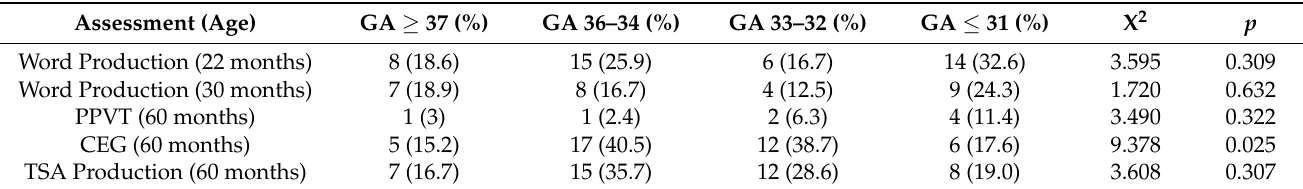
Table 4. Frequency and (percentage) of children with language delay at 22, 30 and 60 months of age (<10th percentile), and GA group comparisons.